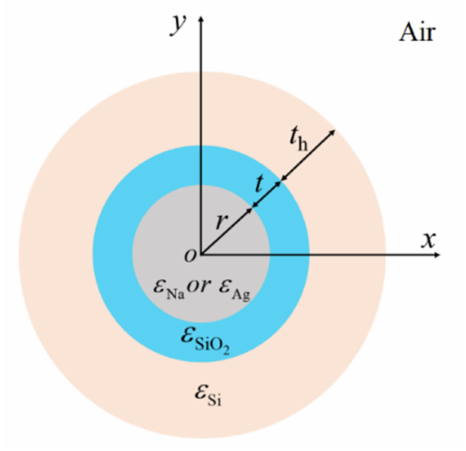
Figure 7. The cross-section of DDCMNWs based on Ag or Na